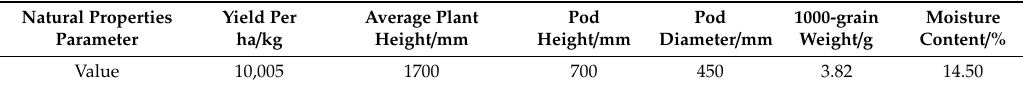
Table 6. Natural properties of